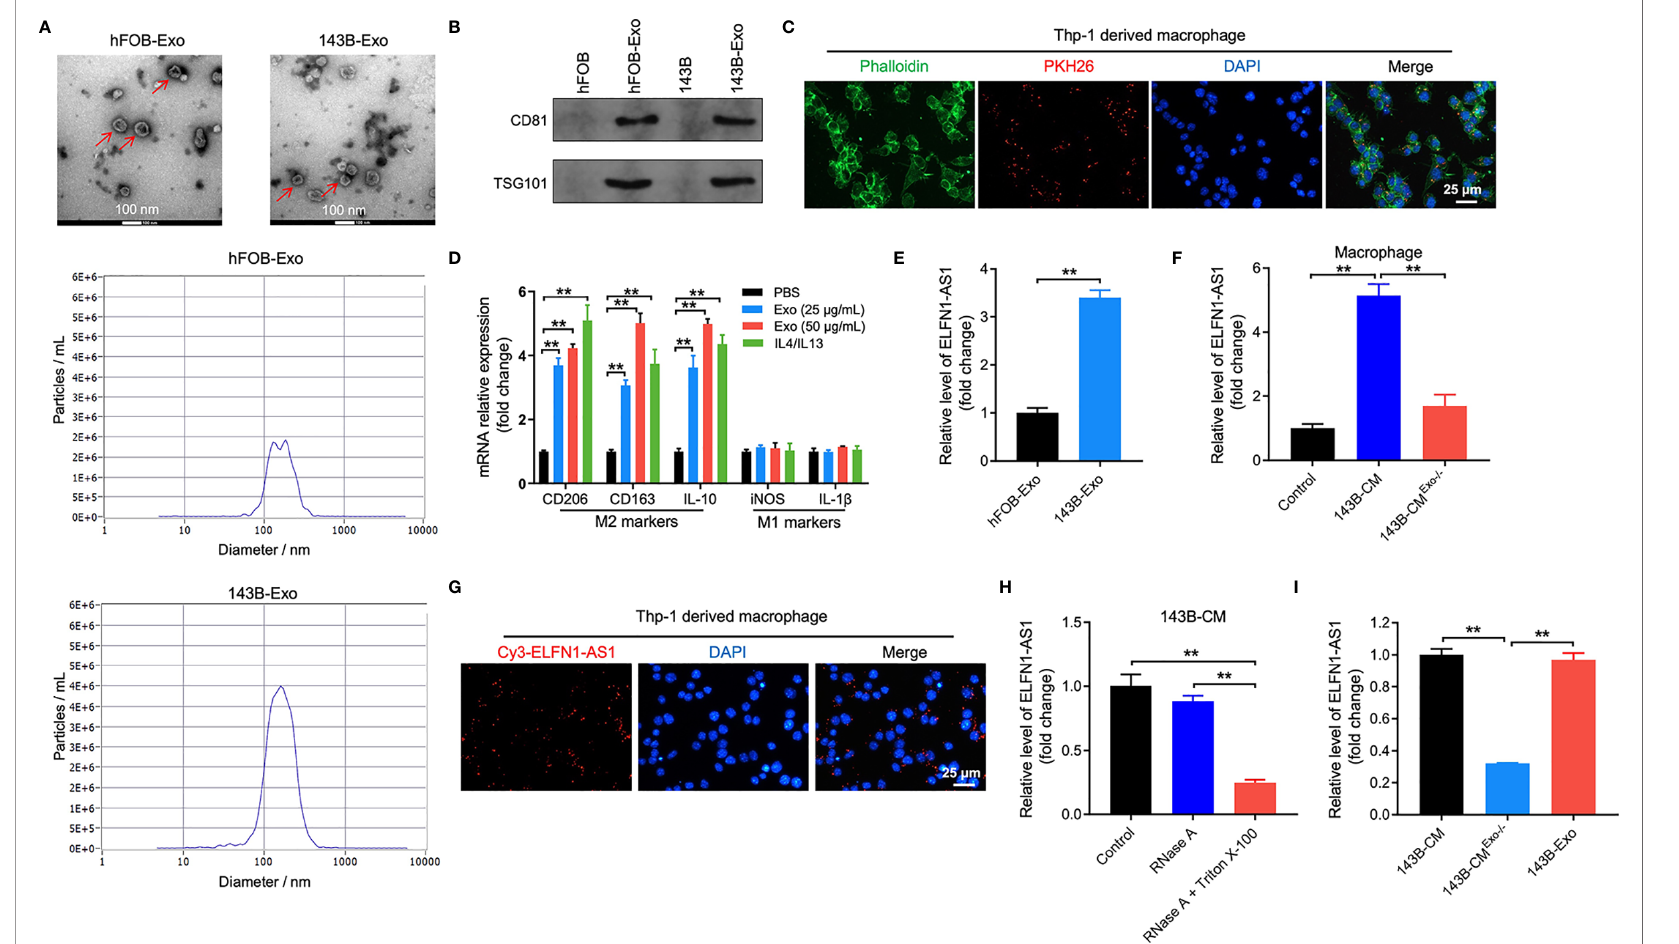
FIGURE 3 | ELFN1-AS1 could be delivered to macrophages by exosomes. (A) Exosomes were isolated from the hFOB and 143B cell CM. The size of exosomes was assessed by NTA assay. The morphology of exosomes was observed by TEM at 100 keV. Red arrow, exosomes. (B) The expression of exosome surface markers CD81 and TSG101 were determined by western blot assay (n = 3). (C) PKH26-labeled exosomes from 143B cells absorbed by macrophages were observed under fl uorescence microscope (n = 3). (D) RT-qPCR analysis of CD206, CD163, IL-10, iNOS, IL-1 b in macrophages treated with indicated exosomes or IL4/ IL13 (n = 3). (E) ELFN1-AS1 level in exosomes isolated from CM of hFOB and 143B cells were detected using RT-qPCR (n = 3). (F) RT-qPCR analysis of ELFN1-AS1 level in macrophages incubated with CM, 143B cell- CM, exosome-depleted 143B cell-CM (n = 3). (G) Cy3-tagged ELFN1-AS1 labeled 143B cells were co-cultured with macrophages for 48 h. Meanwhile, the fl uorescence signal in macrophages was observed by microscopy (n = 3). (H) RT-qPCR analysis of ELFN1-AS1 level in the CM of 143B cells (n = 3). (I) RT-qPCR analysis of ELFN1-AS1 level in 143B cell-Exo, 143B cell-CM, exosome-depleted 143B cell-CM (n = 3). The signi fi cance between two groups was analyzed by Student ’ s t test or one-way ANOVA respectively. **P <